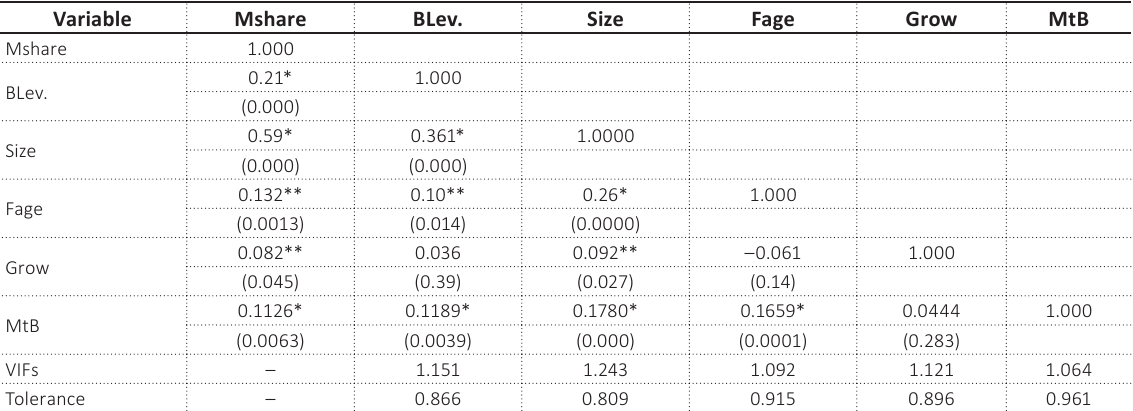
Table 3. Correlation analysis and multicollinearity test